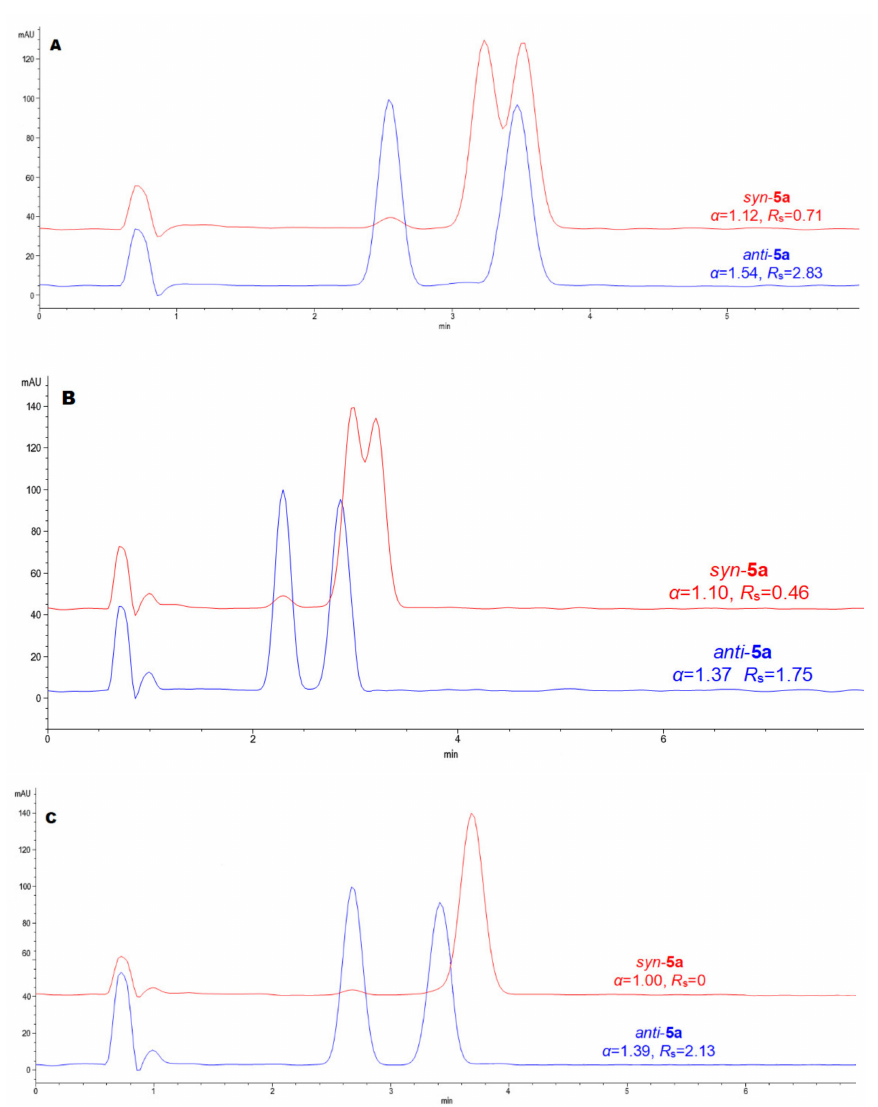
Figure 8. SFC overlay chromatograms of ( ± )- syn - 5a and ( ± )- anti - 5a on Cellulose-SB column with: ( A ) CO 2 /MeOH (80/20, v / v ), ( B ) CO 2 /EtOH (80/20, v / v ) and ( C ) CO 2 /2-PrOH(80/20, v / v ) as mobile